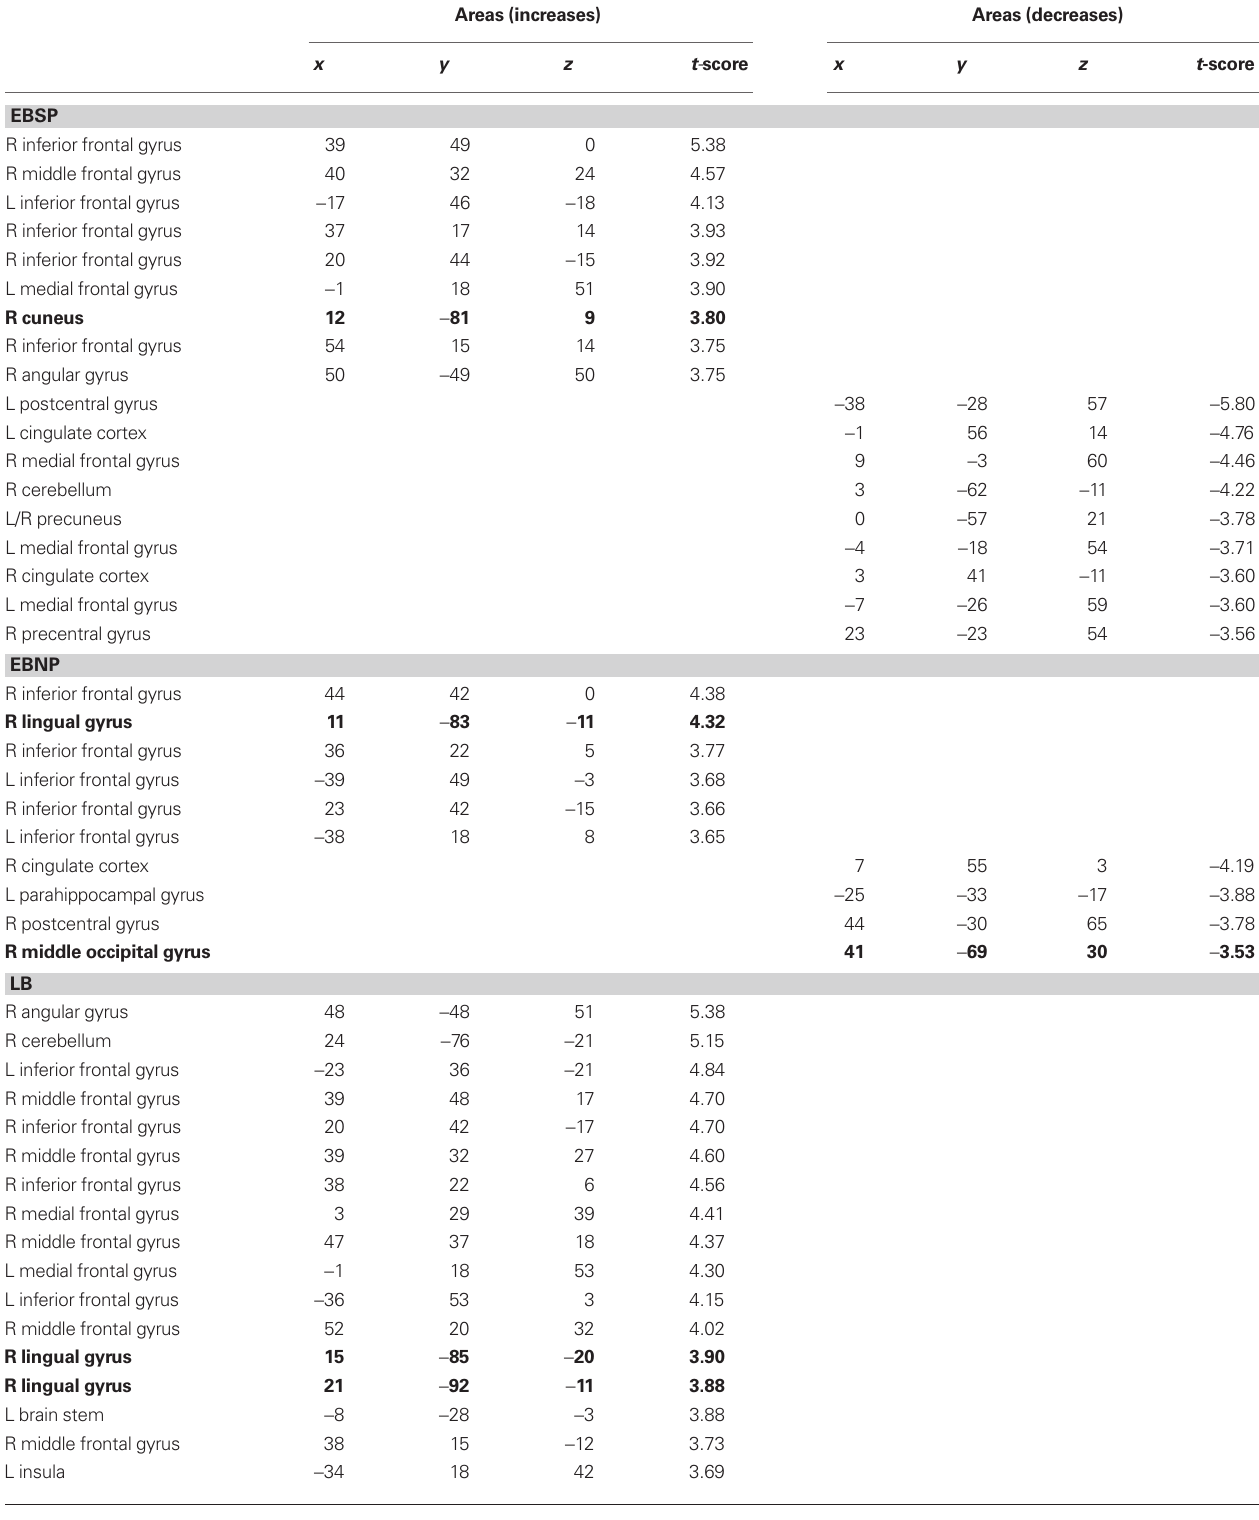
Table 1 | Stereotaxic coordinates and t -values of activation and deactivation foci (coordinates refer to standardized stereotaxic space (Talairach and Tournoux,